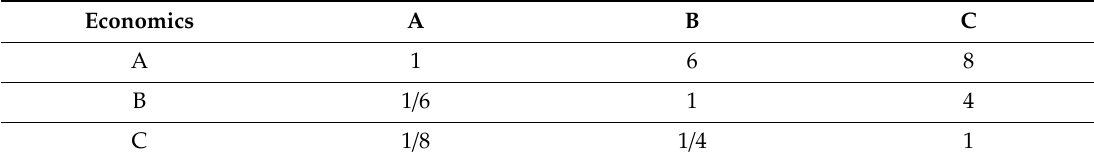
Table 1. AHP calculation example.